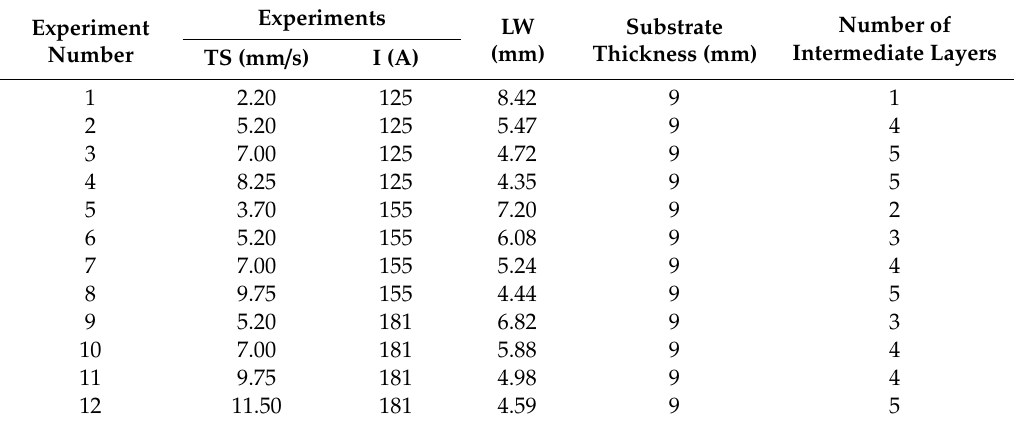
Table 7. Memory calculation table of the number of intermediate layers for the 12